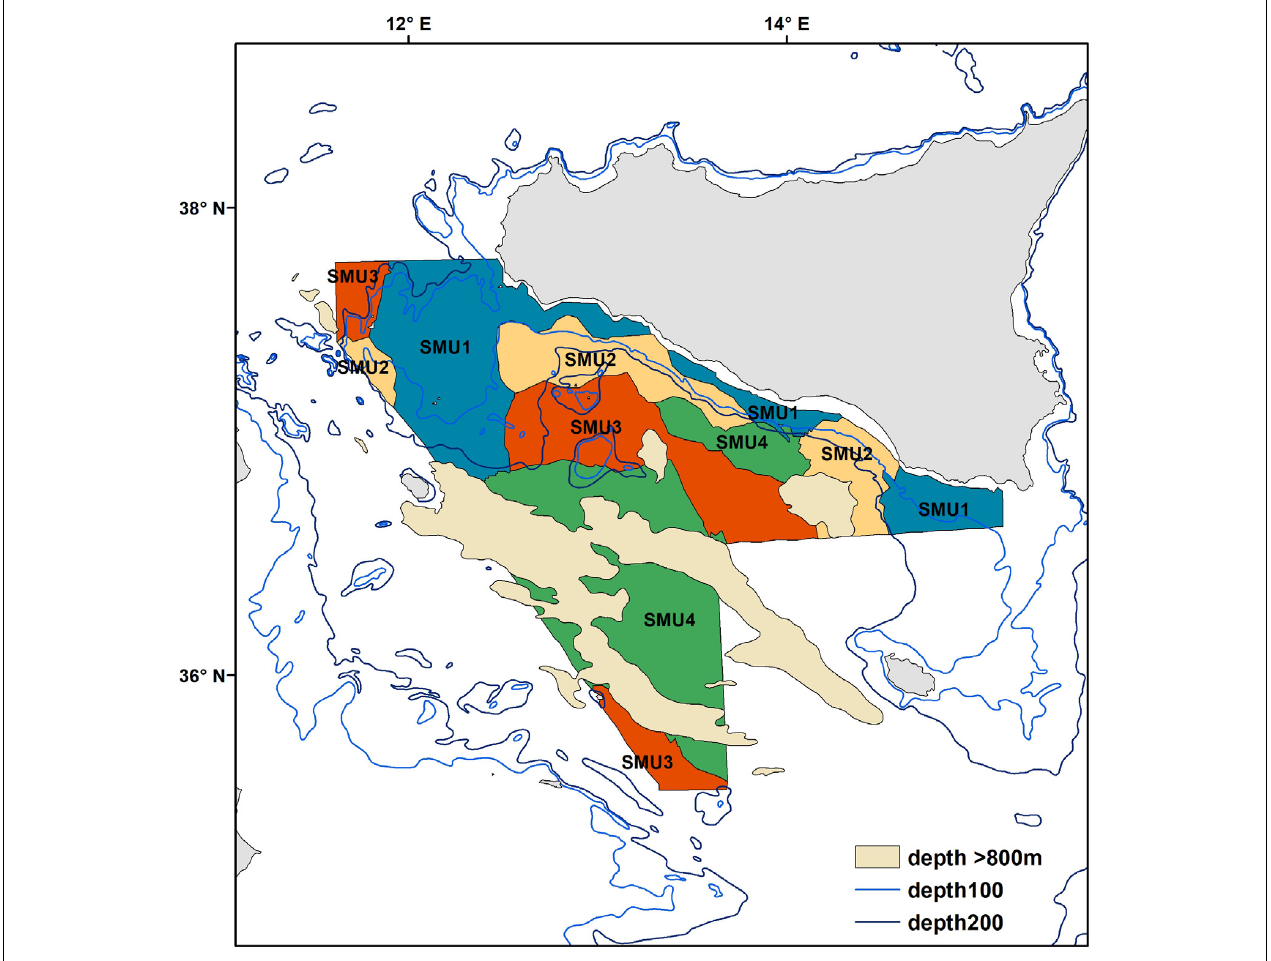
FIGURE 9 | Spatial distribution of the proposed Spatial Management Units for the Strait of Sicily. The areas where depths are over 800 m are shaded in light yellow.